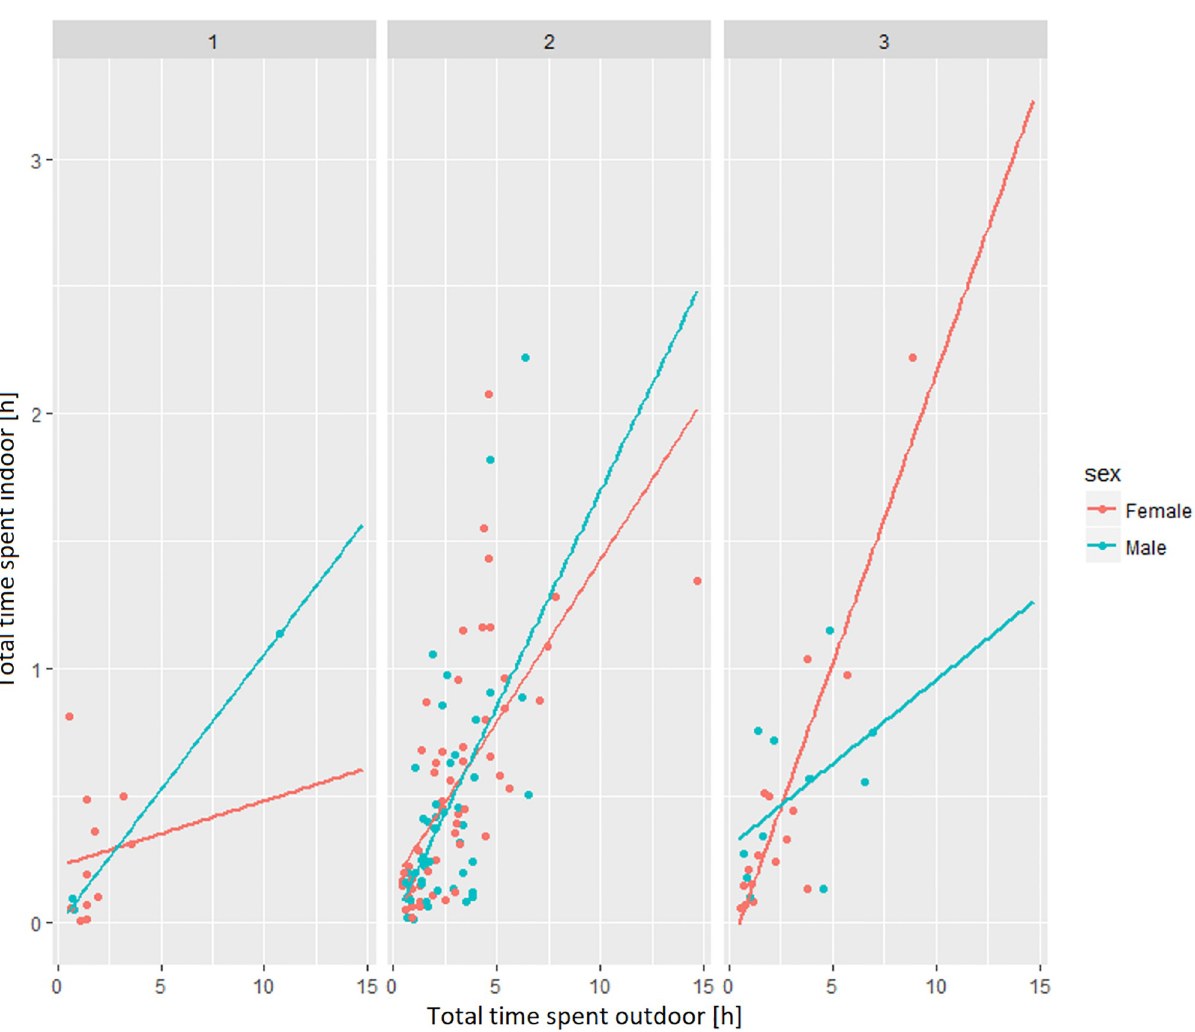
Fig 6. The relationship between time spent indoor and outdoor for different genders and age groups.